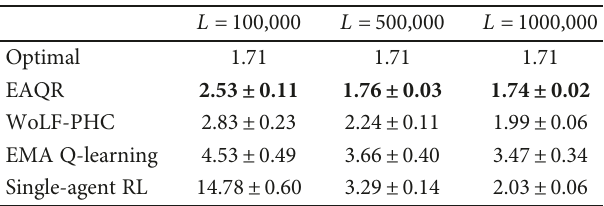
Table 1: Average steps for 4-agent/12-vertex box-pushing (evaluation episodes =50,000).